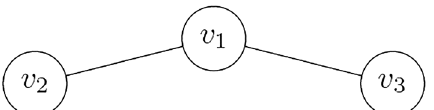
v v v and E 1 , 2 , 3 = { }